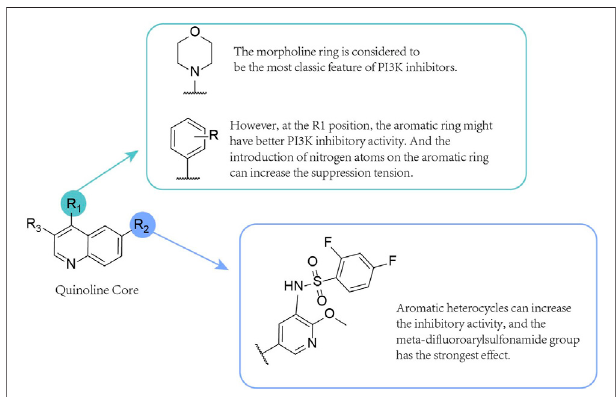
FIGURE 3 | SAR of Quinoline core compounds.